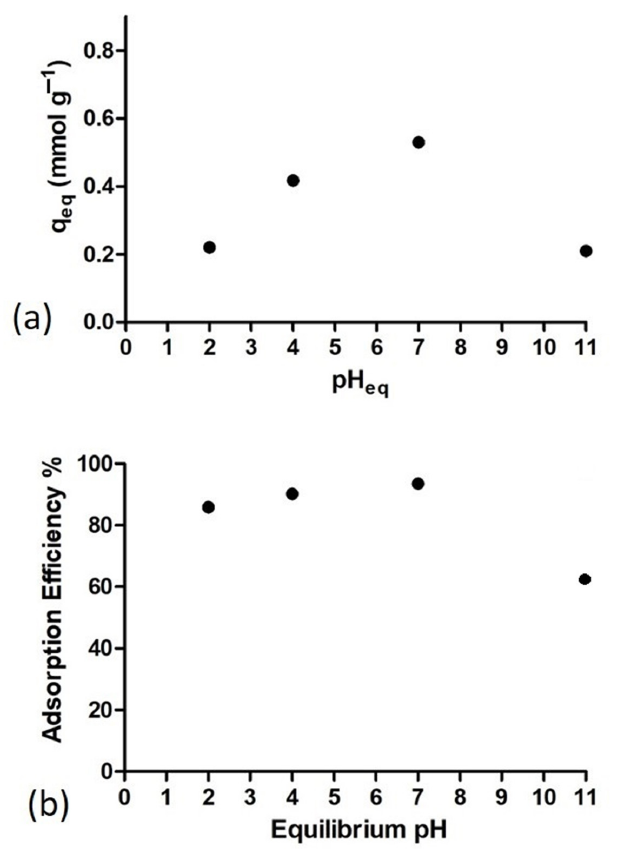
Figure 10. ( a ) Effect of pH on methylene blue of adsorption onto non-woven fabric Ny/ZnO 0.5; ( b ) adsorption efficiency % a different pH (MB concentration = 200 mg/L, nanocomposite content = 20 mg/20 mL, T = 25 °C and t = 60 min).